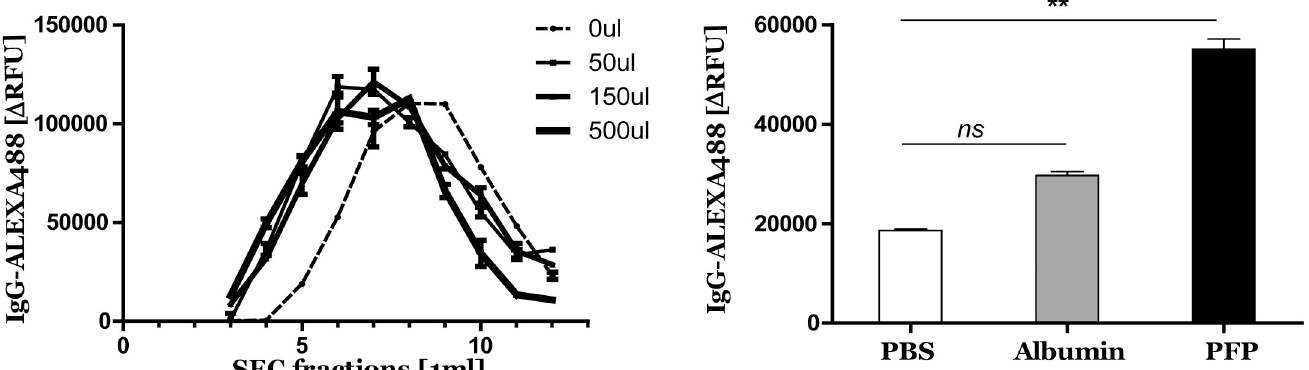
Fig 3. Presence of plasma proteins leads to co-isolation of IgG in the SEC pEV fraction. Alexa488 labelled IgG (1 μ g/ml) was SEC isolated with three different pfp concentrations or PBS. Alexa488 was measured in each eluted SEC fraction by fluorometry (A). Alexa488 labelled IgG (1 μ g/ml) in the presence of pfp, equal protein level albumin (70mg/ml) or PBS was SEC isolated and Alexa488 was measured by fluorometry (B). Two-way ANOVA with Bonferroni’s post hoc test was used to compare PBS vs. additives, �� p < 0.01. https://doi.org/10.1371/journal.pone.0236508.g003 were isolated by conventional SEC or extended SEC (eSEC) columns in parallel. Obtained elu- tion fractions were analysed and the highest amount of particles were observed in fraction 5 both for SEC and eSEC columns (Fig 4A). Also the pEV particle size distribution detected by